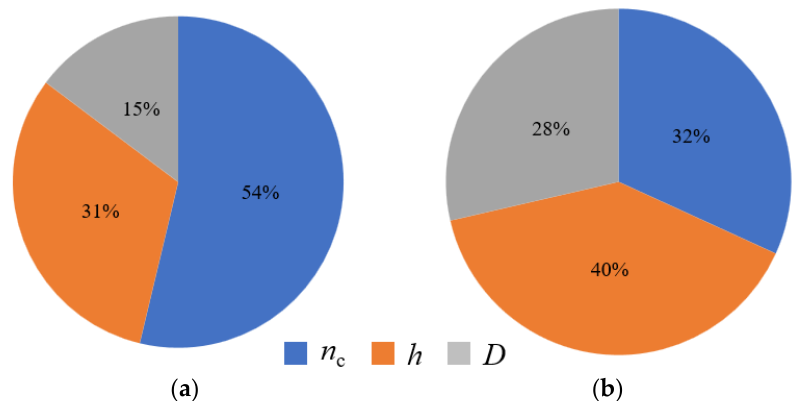
Figure 5. The proportional weight of the three factors on ( a ) the surface roughness and ( b ) the material removal rate.